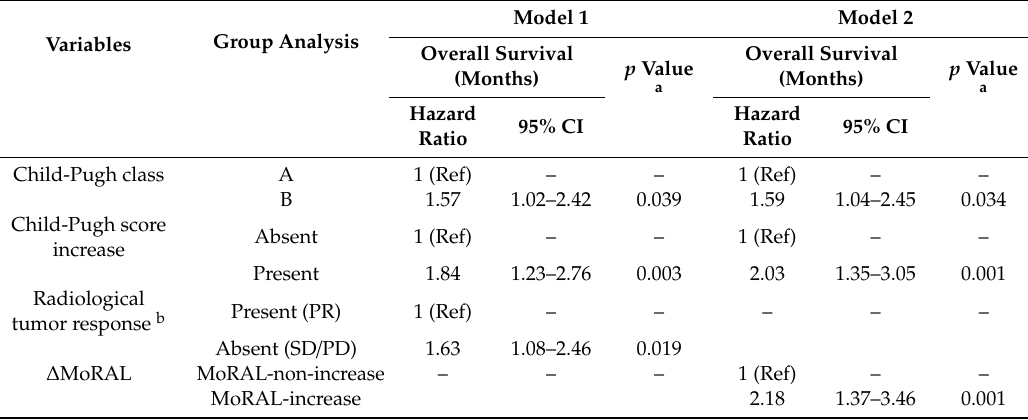
Figure 1. Prognostic significance of ∆ MoRAL among the entire study population ( A ) and patients baseline MoRAL score ≤ 89.5 ( B ) and > 89.5 ( C ) in the training cohort.